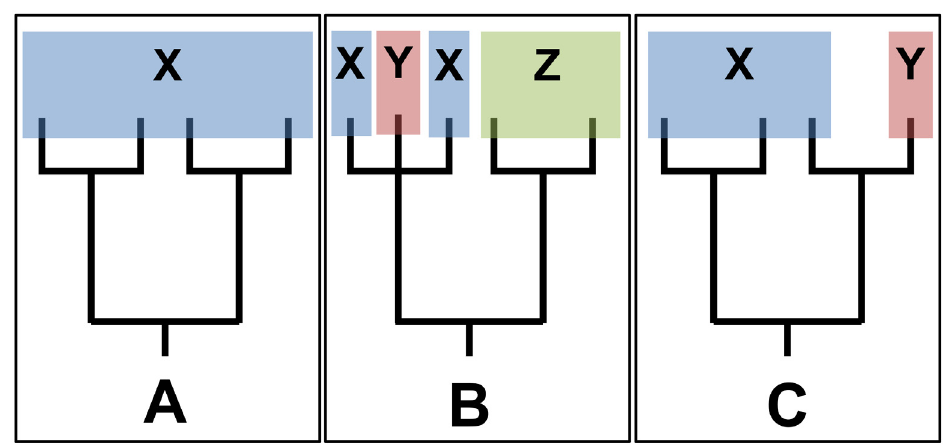
Fig 2. Source locations for rainbow trout (green triangles), westslope cutthroat trout (red circles), and Yellowstone/Bonneville cutthroat trout (both subspecies indicated with blue squares) sampled from the wild for assay development (large, light-colored shapes) and for assay testing (small, dark- colored shapes). The source locations for one rainbow trout sample obtained from Alaska (USA), all hatchery-derived fish, and the Pacific salmon congeners used in assay testing are not shown here, but are listed in Table